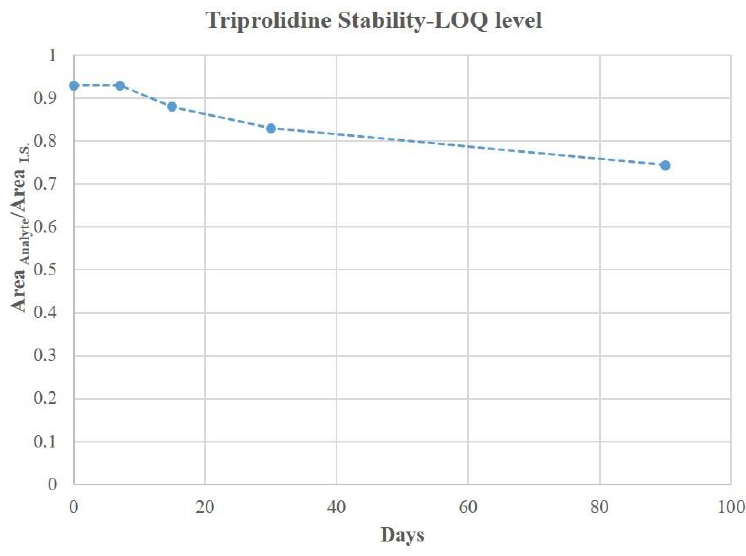
Figure 7. Triprolidine concentration trend over a period of 90 days chosen for stability control (LOQ level). On the y-axis is reported the analyte area vs IS area ratios.